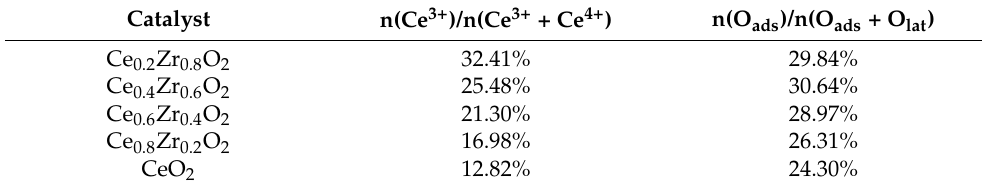
Table 2. XPS analysis of Ce x Zr 1 − x O 2